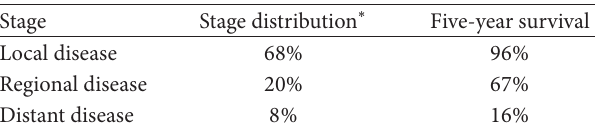
Table 1: Endometrial cancer stage distribution and five-year sur- vival.